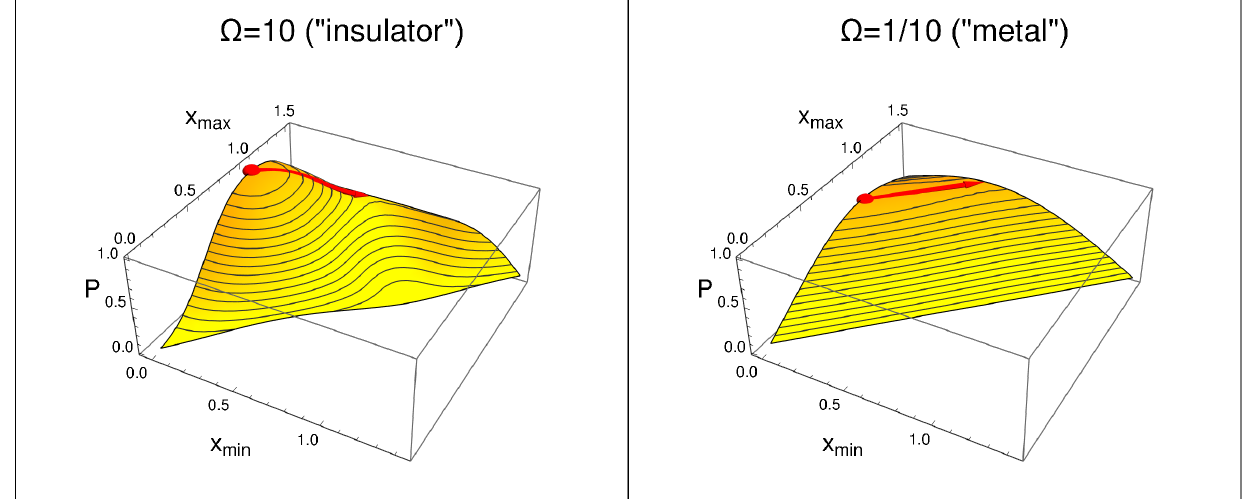
Figure 3. Probability to find an electron between x min and x max , P ( D ) , Equation (1), for large opacity of the wall ( Ω = 10, left, “insulator”), and small opacity ( Ω = 1/10, right, “metal”). The small red sphere indicates P max , Equation (2). The arrow follows a translation of the maximum probability domain, D max , Equation (3), strongly changing the probability P for large Ω , weakly changing it for small Ω